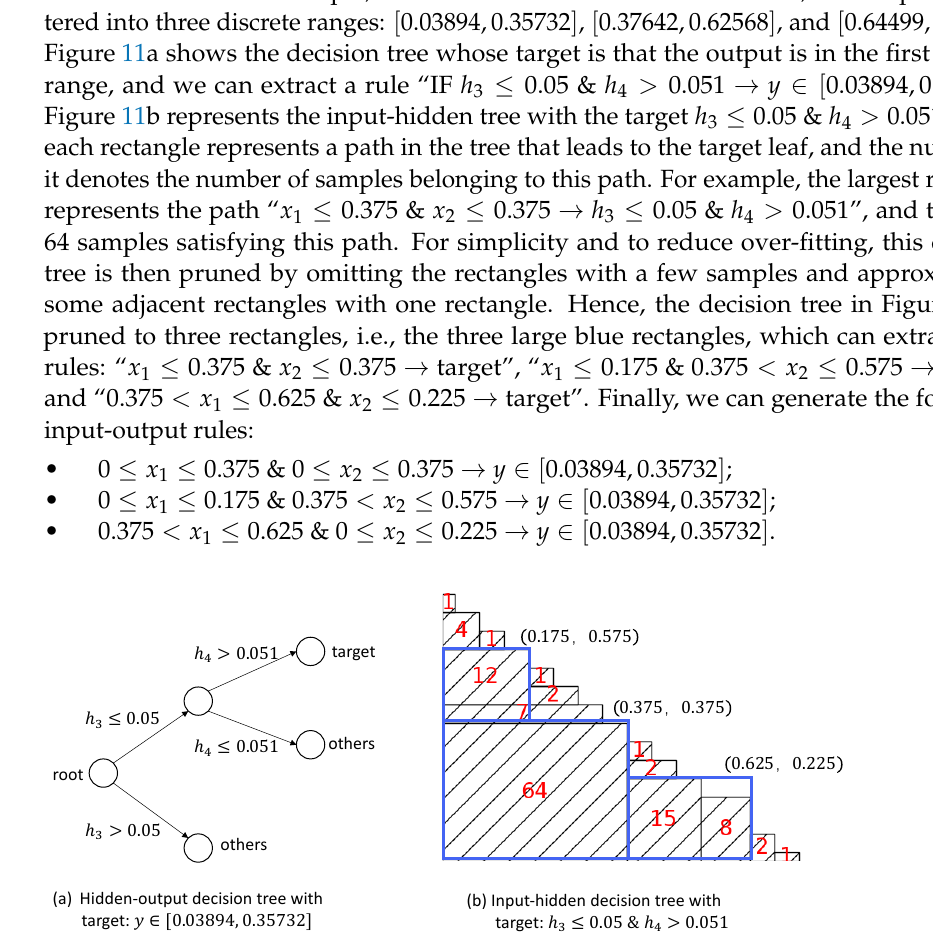
Figure 11. Decision trees for the target y ∈ [ 0.03894,0.35732 ]